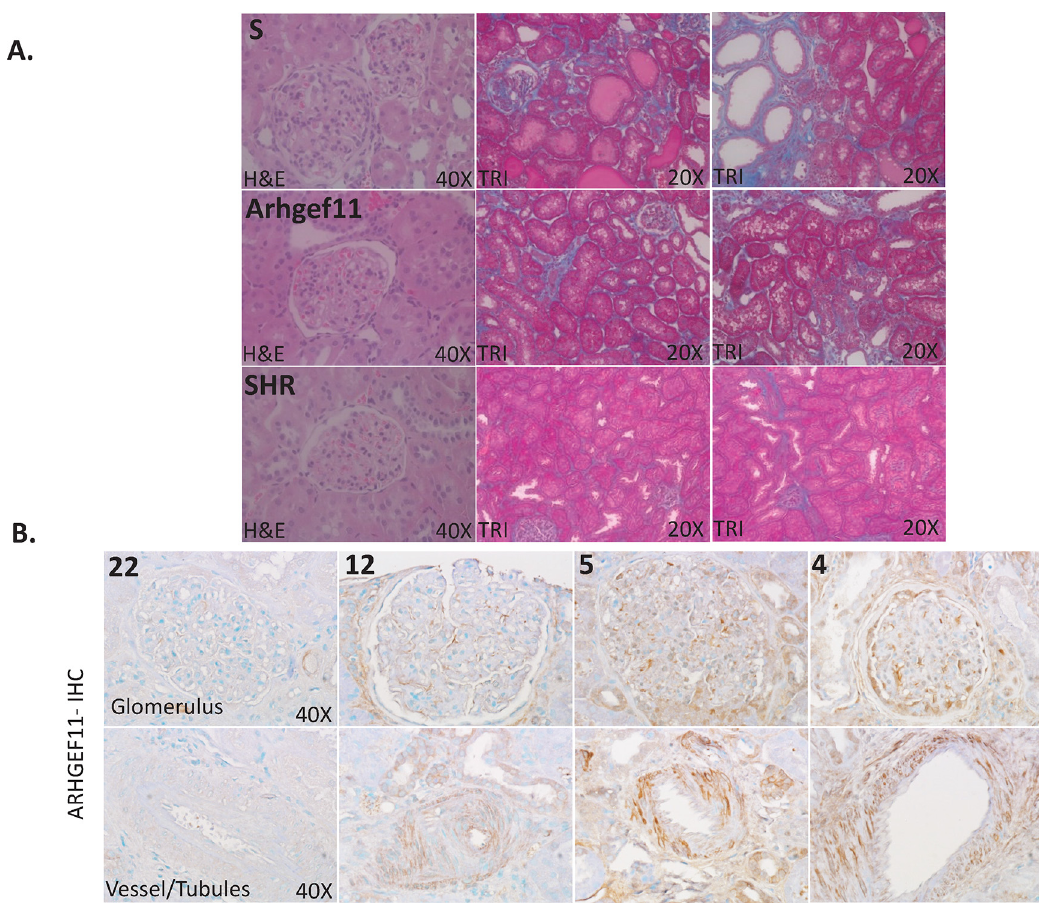
Fig 2. Kidney pathology in the rat and immunohistological staining of ARHGEF11 in human kidney biopsies. ( A ) Representative glomerular and tubulointerstitial images for S, Arhgef11-congenic, and SHR at week 24. The S rat demonstrated glomerular injury (mesangial expansion, glomerulosclerosis, etc), tubular injury, and interstitial fibrosis (tubule atrophy, immune cell infiltration, and/or fibrosis), consistent with detailed histological analysis previously described.[9] Both the Arhgef11-congenic and SHR demonstrated less glomerular and tubular injury compared to S. ( B ) ARHGEF11 staining in human kidney biopsy material from patients with various etiologies, including control (biopsy 22-no specific renal pathology; nephrectomy subsequent to renal pelvic carcinoma); biopsy 12, hematuria and changes compatible with acute tubular necrosis; biopsy 5, hematuria and non-nephrotic range proteinuria; and biopsy 4, diabetic glomerulosclerosis, interstitial fibrosis, and tubular necrosis).A representative image of staining in the glomerulus is shown in the upper panel and vessel and some tubular staining is illustrated in the lower